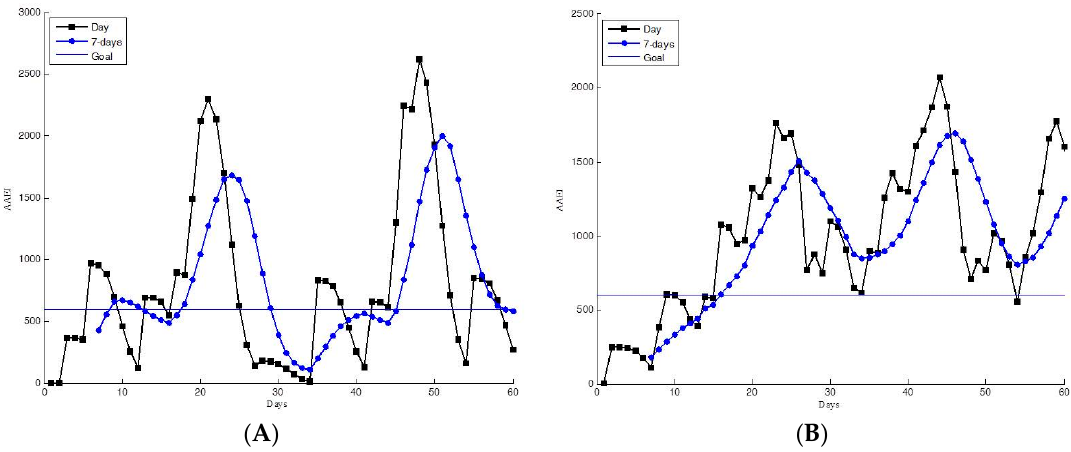
Figure 8. Participants with high AAEI values, as determined in the 60-day trial. ( A , B ) Several high AAEI values above 600.